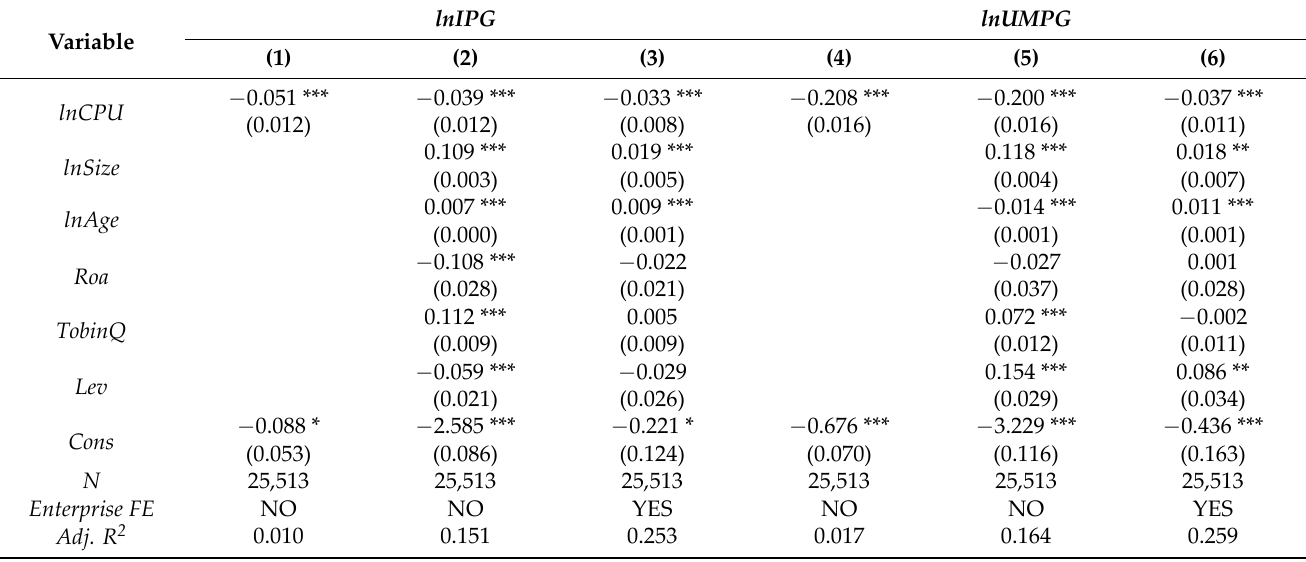
Table 3. Effect of CPU on